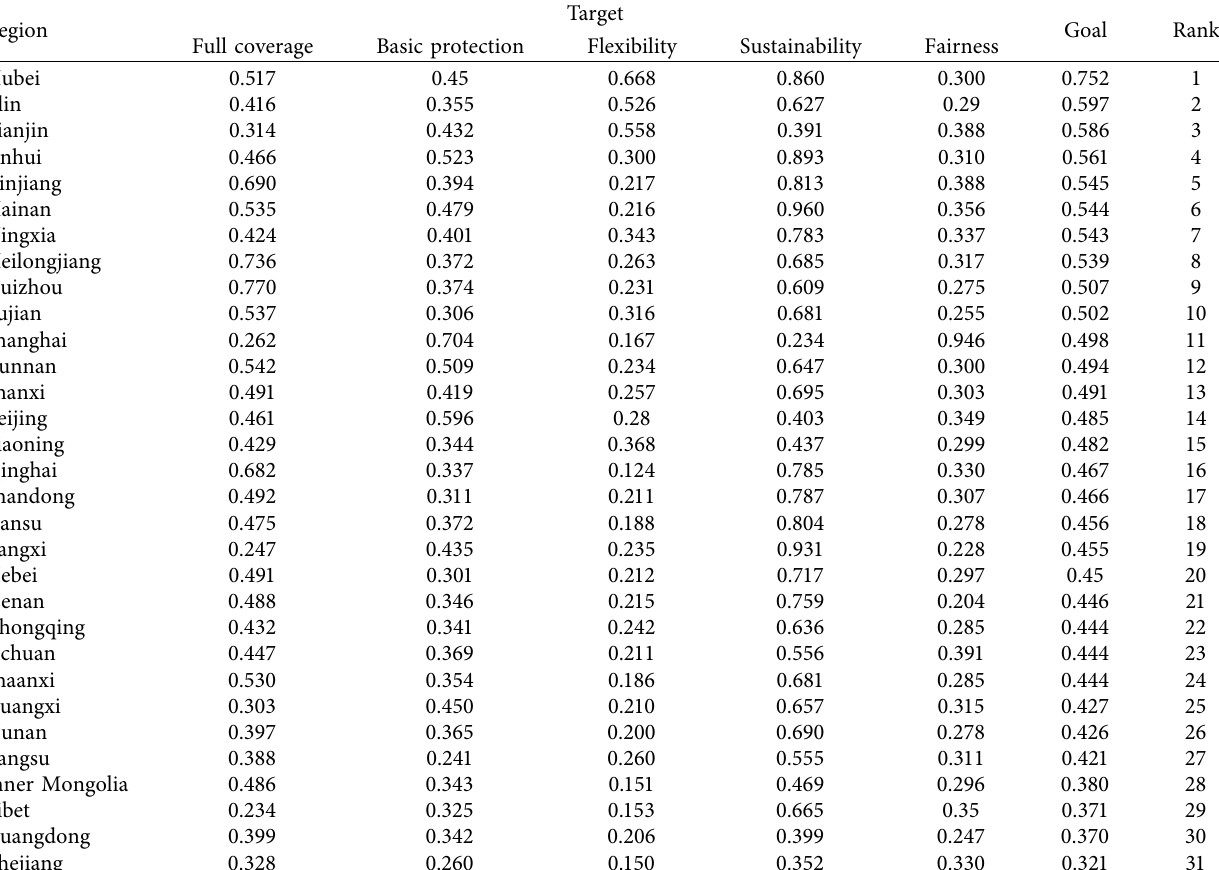
Table 2: EIUR: security ability index and rank in